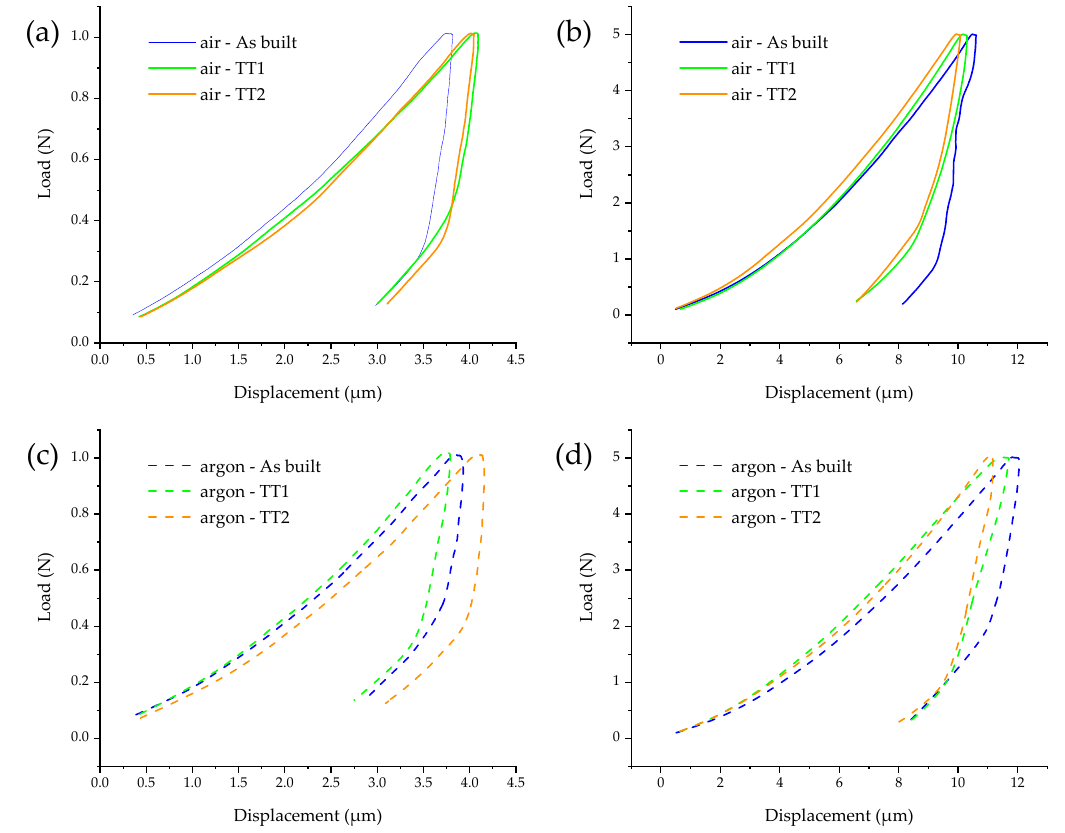
Figure 13. P–h curves for micromechanical behavior of samples. ( a ) Air atmosphere, 1 N; ( b ) air atmosphere, 5 N; ( c ) argon atmosphere, 1 N; and ( d ) argon atmosphere, 5 N. Table 7. Elastic recovery values employing a load of 5